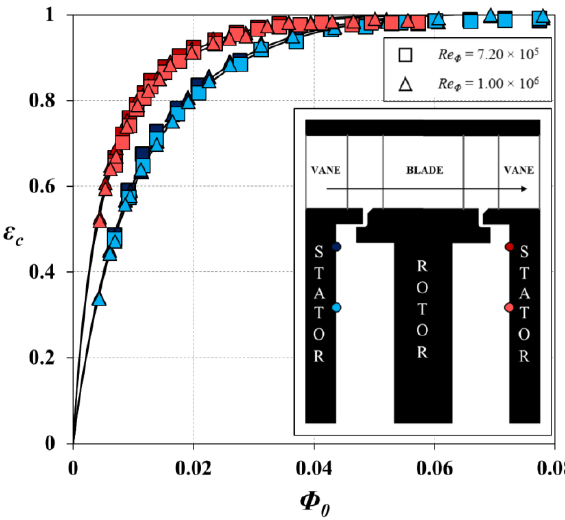
Figure 9. Variation of ε c with Φ 0 for single radial-clearance seal in the upstream (blue symbols) and downstream wheel-space (red symbols) at r / b = 0.958 (dark symbols) and 0.85 (light symbols) ( C F = 0.29) (symbols denote data; lines are theoretical curves).